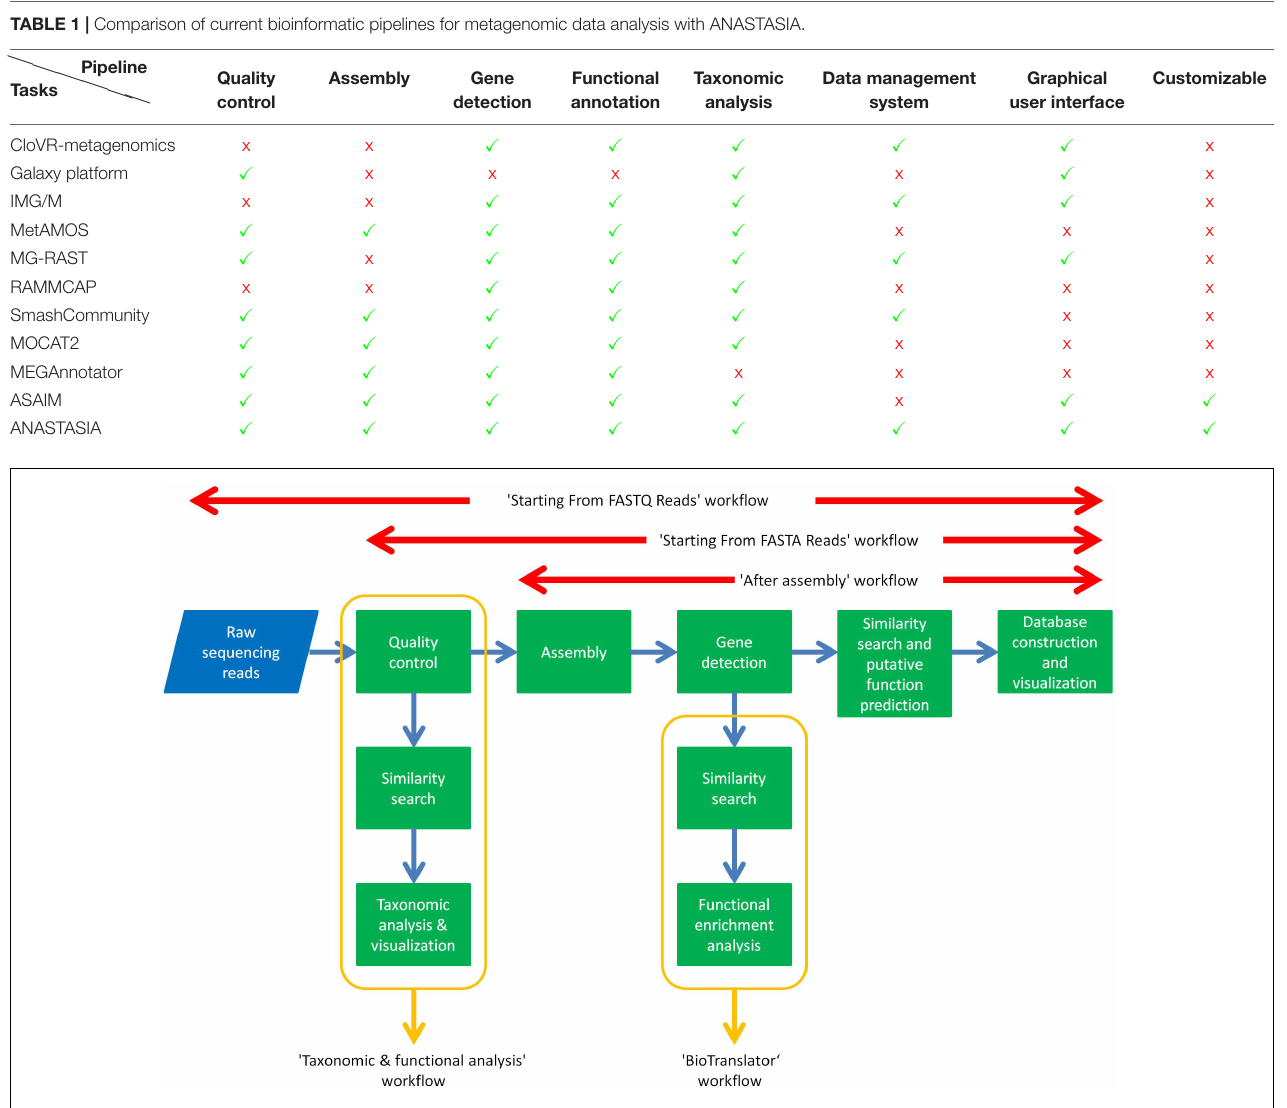
FIGURE 7 | Summary of ANASTASIA’s